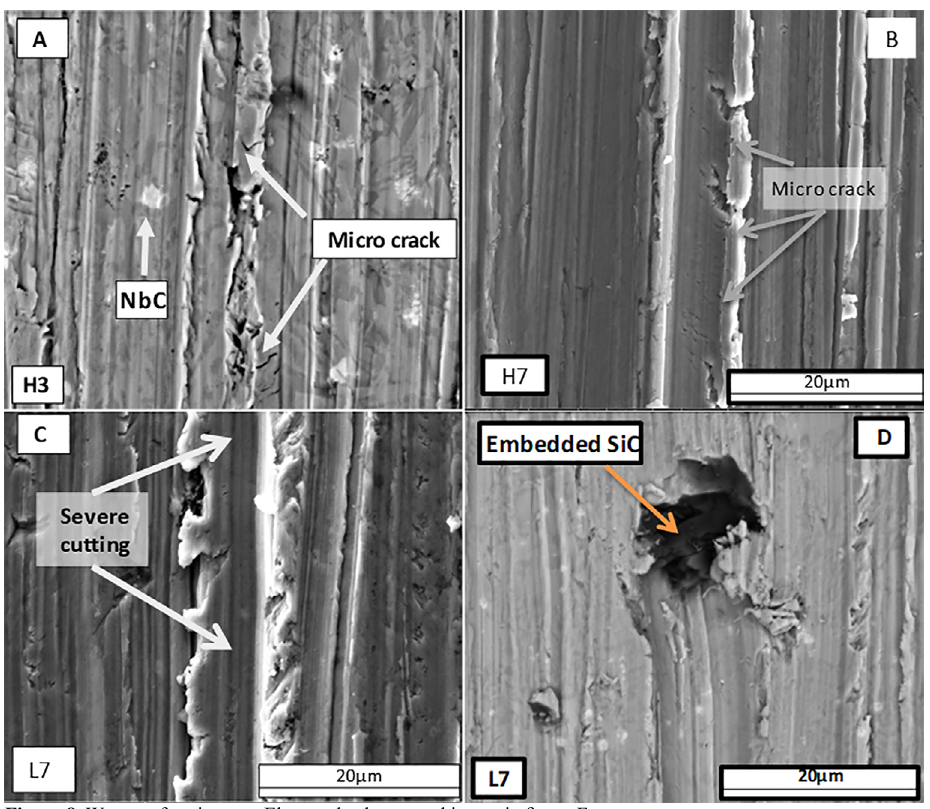
Figure 8. Worn surface images. Electron backscattered image in figure F.